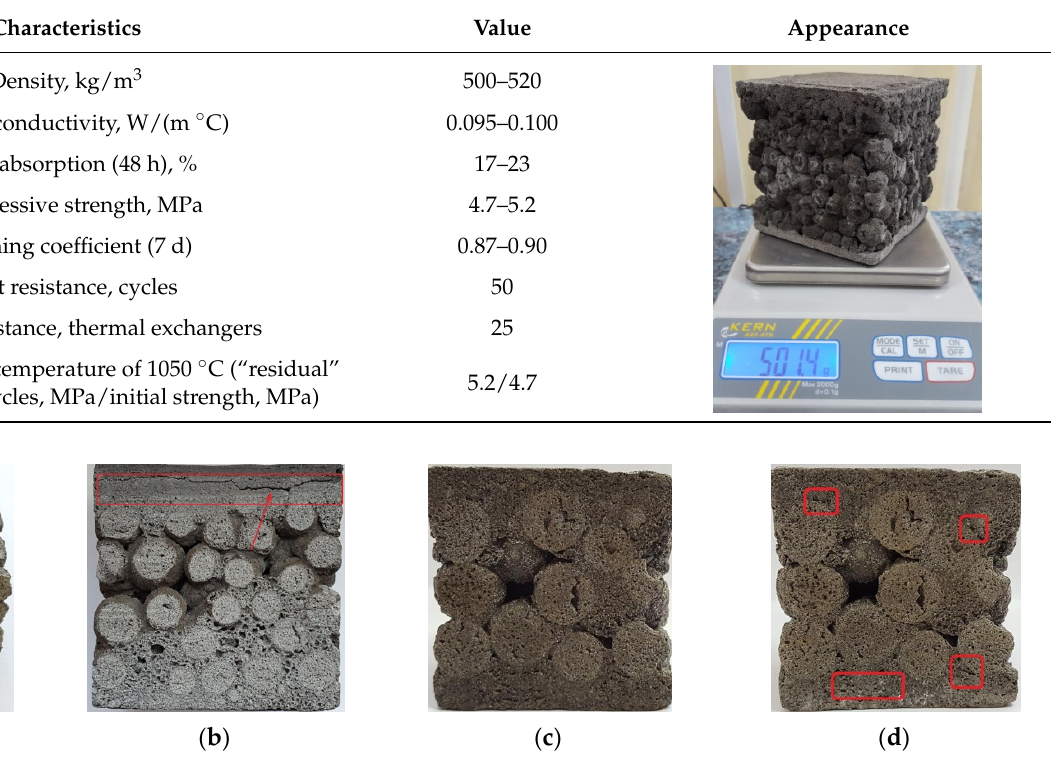
Figure 14. Appearance of composite material samples after testing: ( a ) after compression test; ( b ) destruction of a multilayer sample; ( c ) before testing for thermal resistance; ( d ) after 25 thermal cy- cles of thermal resistance tests.